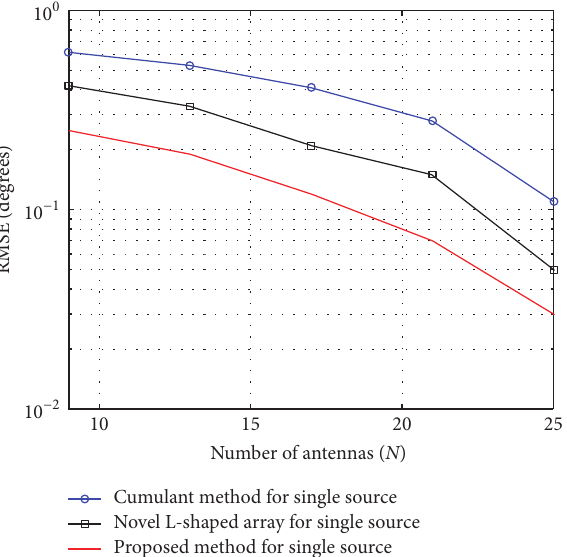
Figure 9: RMSE of azimuth-elevation versus number of antennas at SNR = 6dB for single source located at (65 ∘ , 72 ∘ ) using proposed method, novel L-shaped, and cumulant